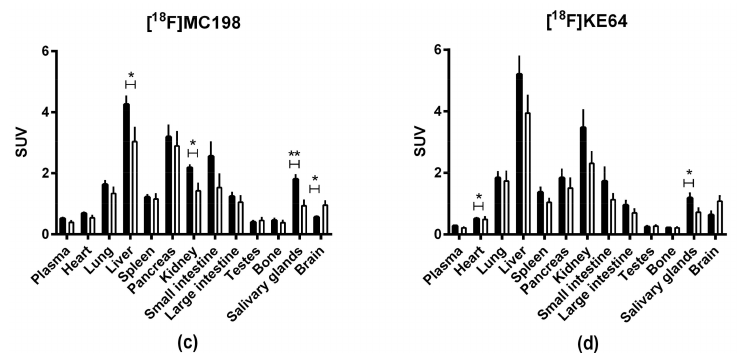
Figure 5. ( a , b ) Whole brain time-activity curves and ( c , d ) biodistribution profile 45 min p.i. of [ 18 F]MC198 and [ 18 F]KE64. Data are presented as mean ± SEM. Statistical differences are marked with a horizontal capped line (* p < 0.05, ** p < 0.01).